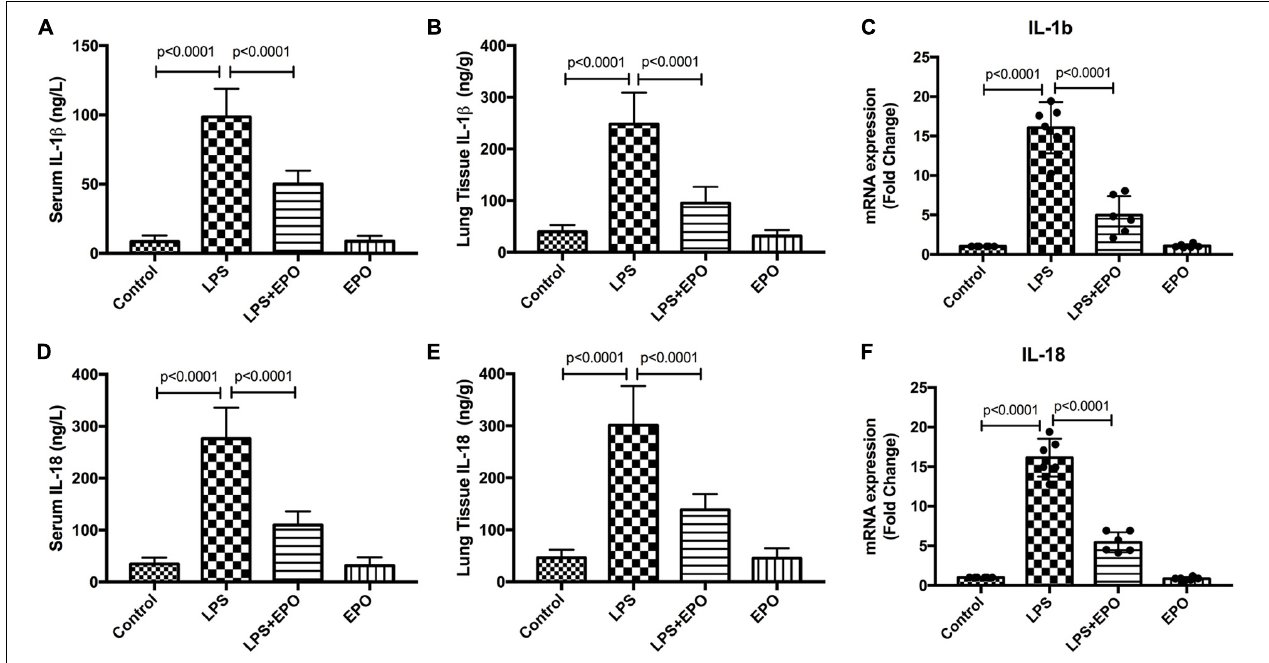
FIGURE 2 | EPO downregulated the expression and concentration of IL-1 β and IL-18 in LPS-induced ALI. EPO (5 U/g) was injected into the peritoneal cavity of mice after LPS (15 mg/kg) stimulation. The mice were sacrificed 8 h later, and the serum was obtained to measure the concentrations of IL-1 β and IL-18 (A,D) by ELISA. The lung tissues were harvested to measure the concentrations of IL-1 β and IL-18 (B,E) by ELISA, and the mRNA expression levels of pro-IL-1 β and pro-IL-18 (C,F) were measured by QPCR. The data are presented as the mean ± SD. The differences among groups were assessed by one-way ANOVA and the post hoc test (Turkey method) was applied to investigate the differences one by one. n = 8 per